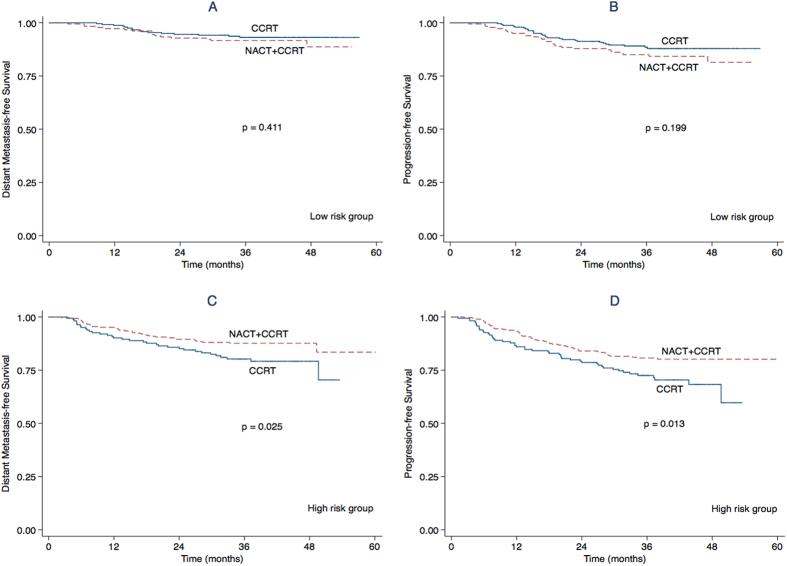
Kaplan-Meier distant metastasis-free survival curves and progression-free survival curves for patients with locally advanced NPC in the low-risk (A,B), and high-risk groups (C,D) stratified by the CCRT and NACT + CCRT.